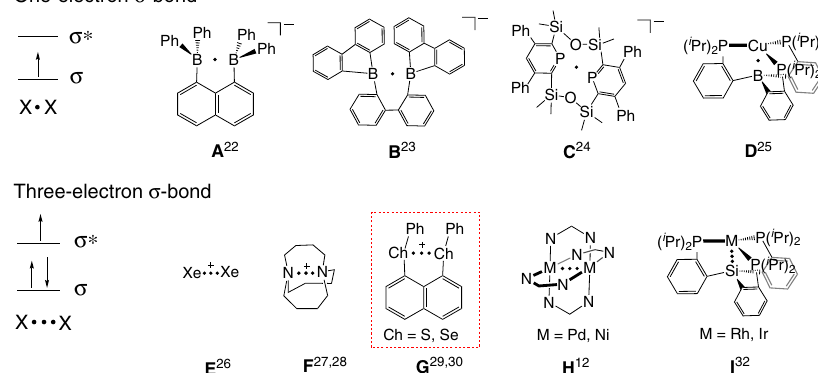
Fig. 1 Schematic representation of odd-electron σ -bonds and selected examples. a The B·B one-electron σ – bond proved by EPR. b The B·B one-electron σ – bond proved by X-ray diffraction. c The P·P one-electron σ – bond. d The Cu·B heteronuclear one-electron σ – bond. e The Xe·Xe one-electron σ – bond. f The N ∴ N three-electron σ – bond. g The S ∴ S and Se ∴ Se three-electron σ – bonds. h The Pd ∴ Pd and Ni ∴ Ni three-electron σ – bonds. i The Rh ∴ Si and Ir ∴ Si heteronuclear three-electron σ –